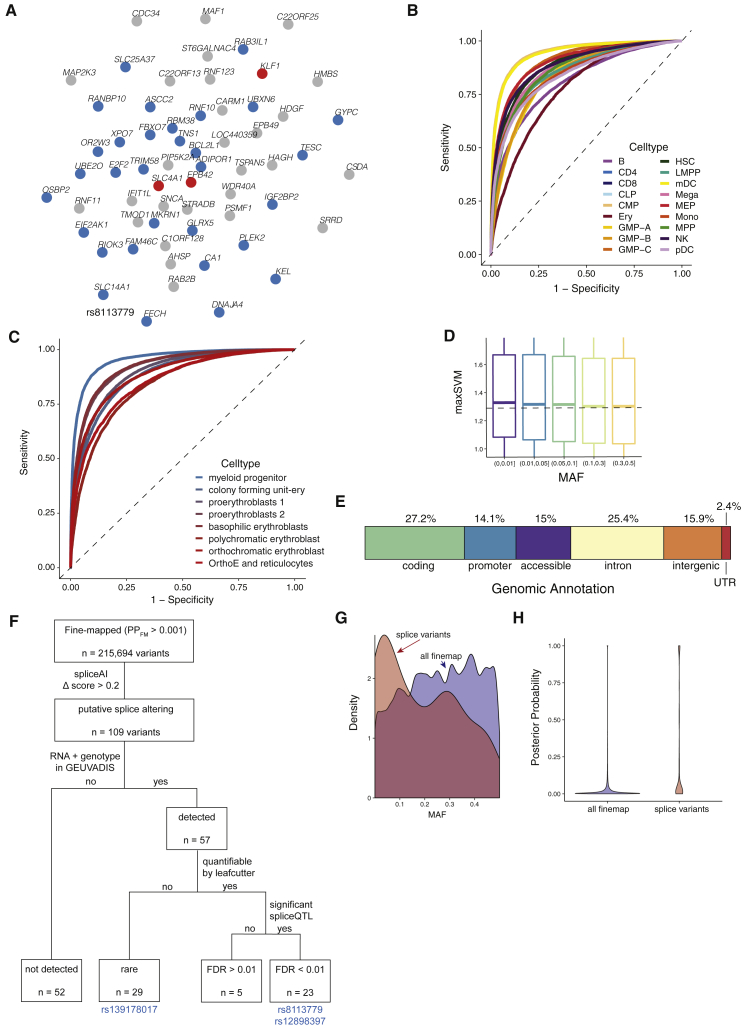
Network Examples and Functional Annotation, Related to Figure 2A, A zoom-in example of the coexpression network, including connected genes with a very high correlation cut-off (0.8). Blue dots represent genes detected by GWAS, according to VEP worst-consequence annotation, red dots represent GWAS genes that are also Mendelian genes for blood disorders. Three Mendelian genes are identified, all of them involved in spherocytosis and other red-cell disorders. B-C, Receiver operating characteristic (ROC) curves for measuring classification performance of deltaSVM in two datasets: B) 18 hematopoietic populations sorted from bone marrow, and C) 8 stages of primary erythroid differentiation. D, Association between variant absolute deltaSVM score (maxSVM), reflecting a variant’s predicted disruption of chromatin accessibility, and bins of MAF. Dotted line indicates the median maxSVM score for the MAF 0.3-0.5 bin. E, Rare variants (MAC > 20, MAF < 1%, PPFM > 0.50, conditionally independent) grouped by genomic annotation. F, Flow-chart depicting the steps involved in the identification and validation of blood trait-associated splice variants. G, Density distribution of variant MAF, comparing 109 putative splice variants to all fine-mapped blood trait variants. H, Violin plot of the fine-mapped posterior probability (PPFM) for putative splice variants versus all fine-mapped variants. For variants fine-mapped to multiple blood traits, we used the maximum PPFM.